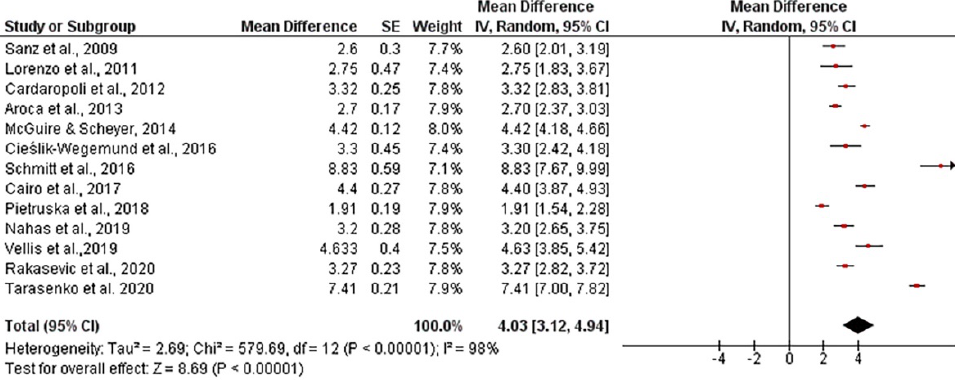
Figure 5. Forest plot for keratinized mucosa width when using autogenous connective tissue. Weighted mean is presented at CI 95%. Heterogeneity was determined using Higgins (I 2 ). A random-effects model was applied. Statistical significance was p < 0.001.